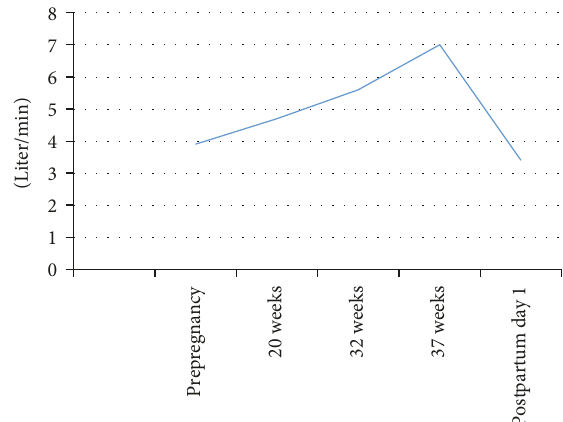
Figure 2: Changes in cardiac output during prepregnancy, antepar- tum, and postpartum